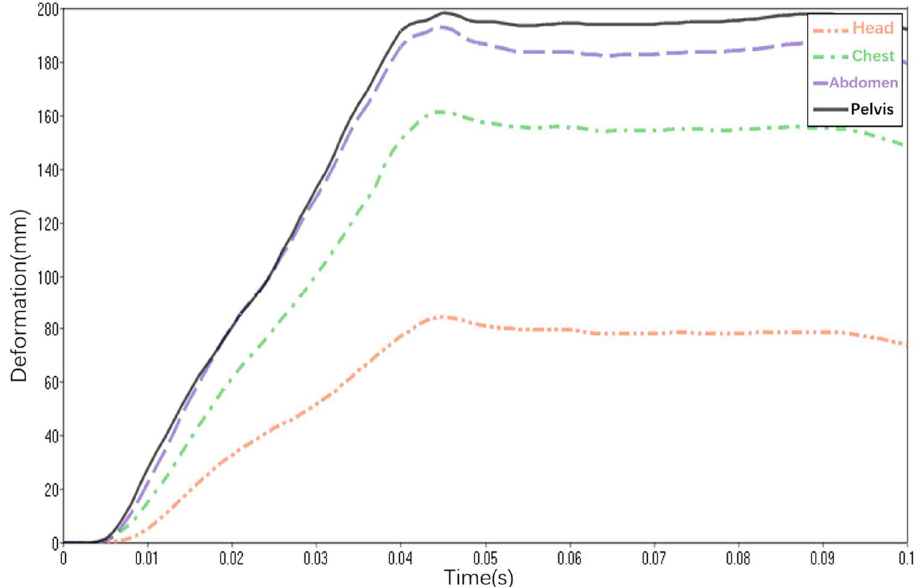
Figure 13. Amount of deformation of spring element at B-pillar.